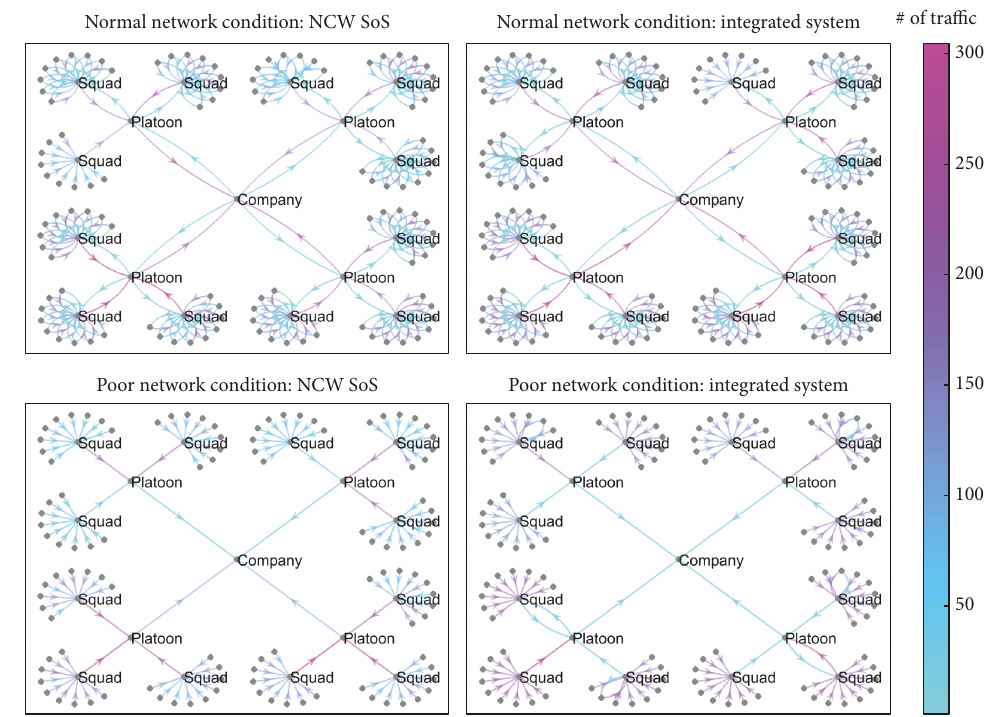
Figure 13: Traffic model results of the SoS and the proposed integrated system for NCW.